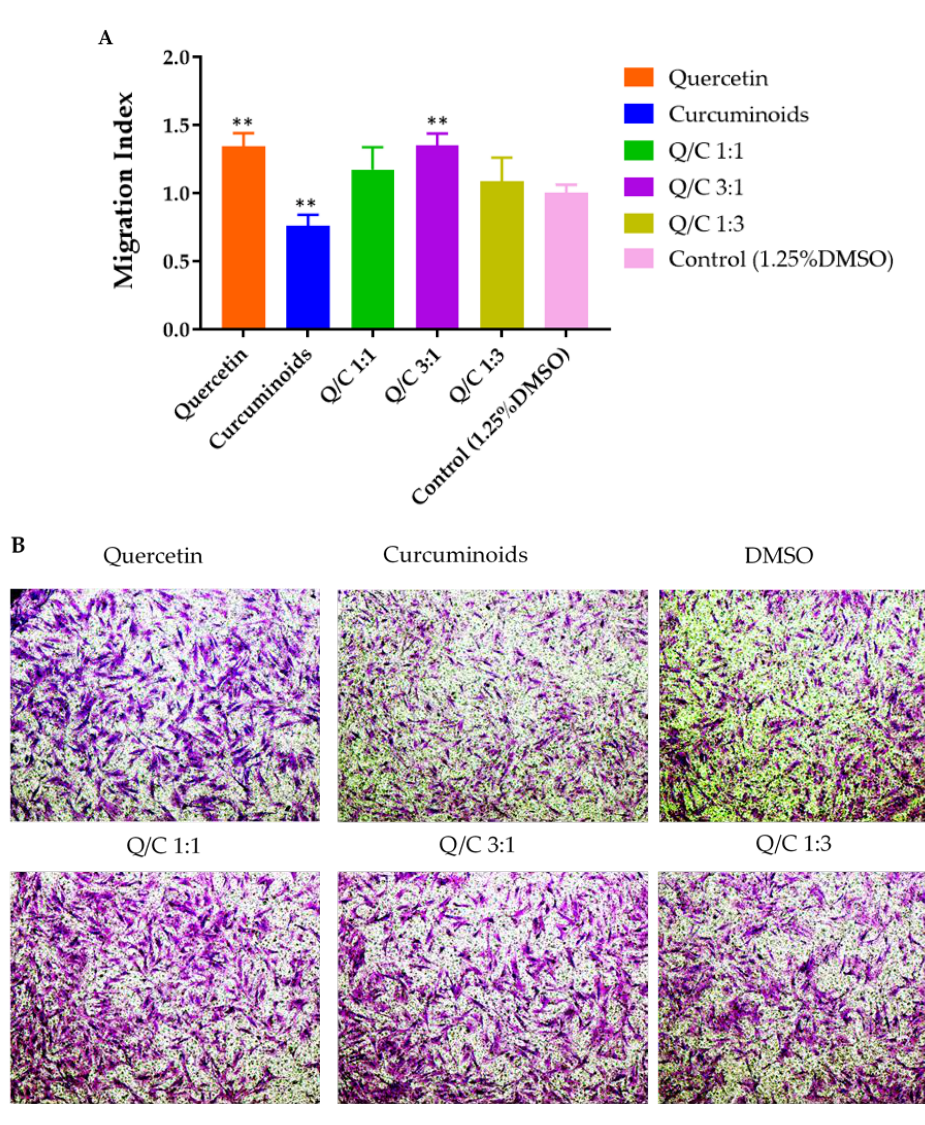
Figure 5. Transwell migration of HDFB cells. ( A ) Migration index of cells treated with quercetin, curcuminoids and quercetin/curcuminoid mixture. ( B ) Representative images showing migrating cells per field after treatment with quercetin, curcuminoids and quercetin/curcuminoid mixture. Data represent mean ± S.D. ( n = 3), and ** p < 0.01 in comparison with control (1.25% DMSO in serum-free DMEM). Scale bars represent 100 µ m.